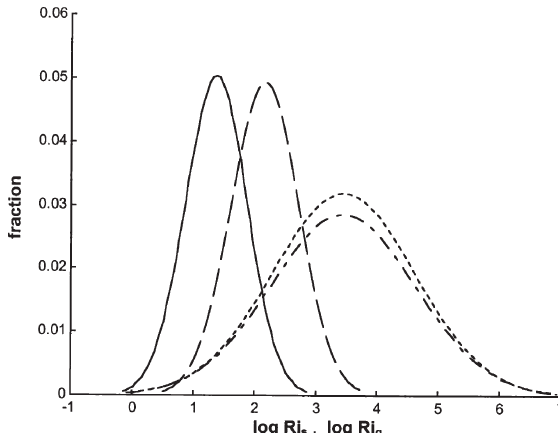
IG . 17. – Gaussian curves adjusted to log Ri s (solid line: unsmoothed; dashed line: 275 m smoothed) and log Ri (dotted line: g unsmoothed; dotted-dashed line: 275 m smoothed), obtained with the Cape Hatteras